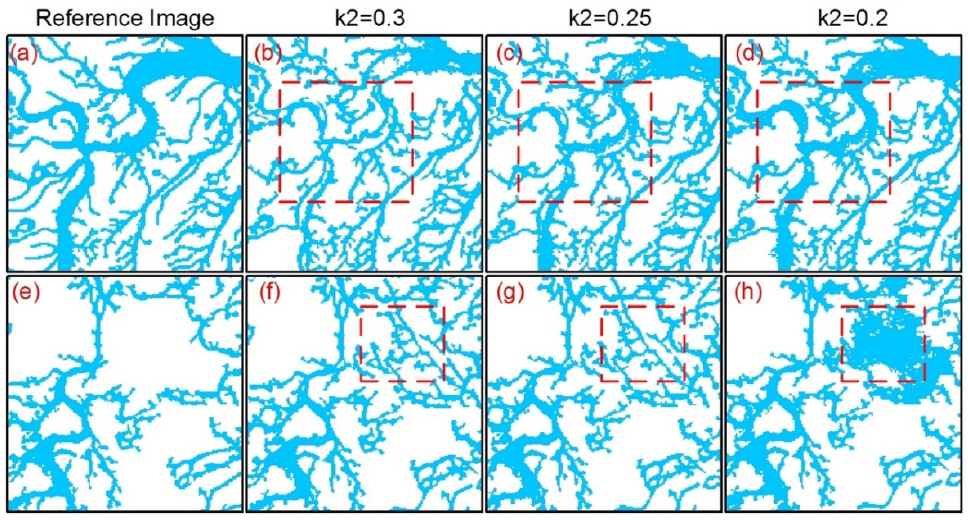
Figure 11. Reference images and wadi extraction results based on different values of k2. As k2 decreases, wide wadis become more and more complete, but over-extractions around small wadis become more and more significant; ( a ) reference images for block 1; ( b – d ) the results for different k2 in block 1; ( e ) reference image for block 2; ( f – h ) the results of different k2 for block 2. Table 5. Performance evaluation of wadi extraction results based on different values of k2.